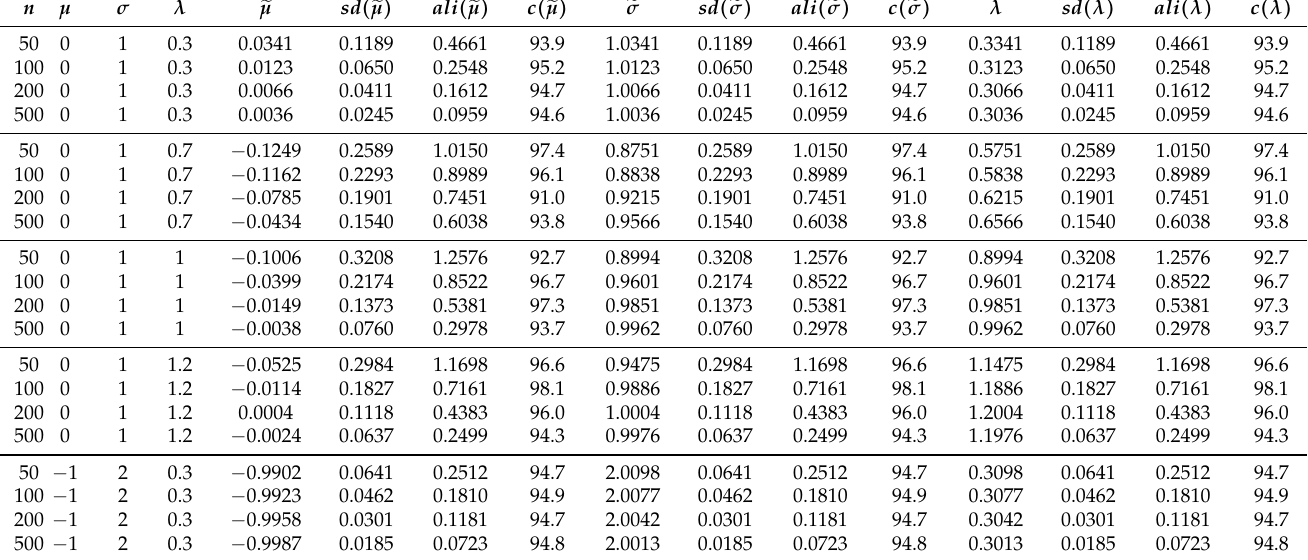
Table 2. ME simulation of 1000 iterations of the model EML ( µ , σ , λ )